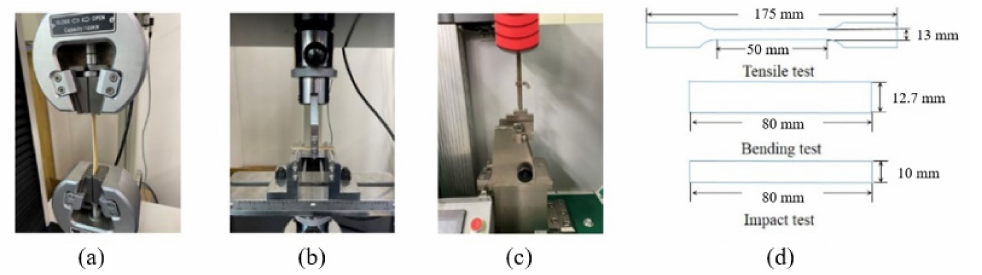
Figure 2. Mechanical properties test and specimens. ( a ) Tensile test, ( b ) Bending test, ( c ) Impact test and ( d ) Specimens picture.